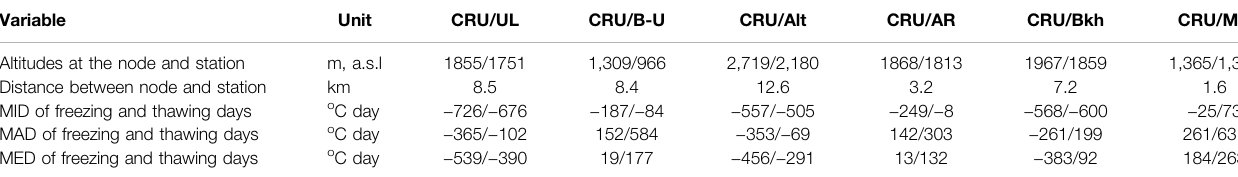
MAD of freezing and thawing days